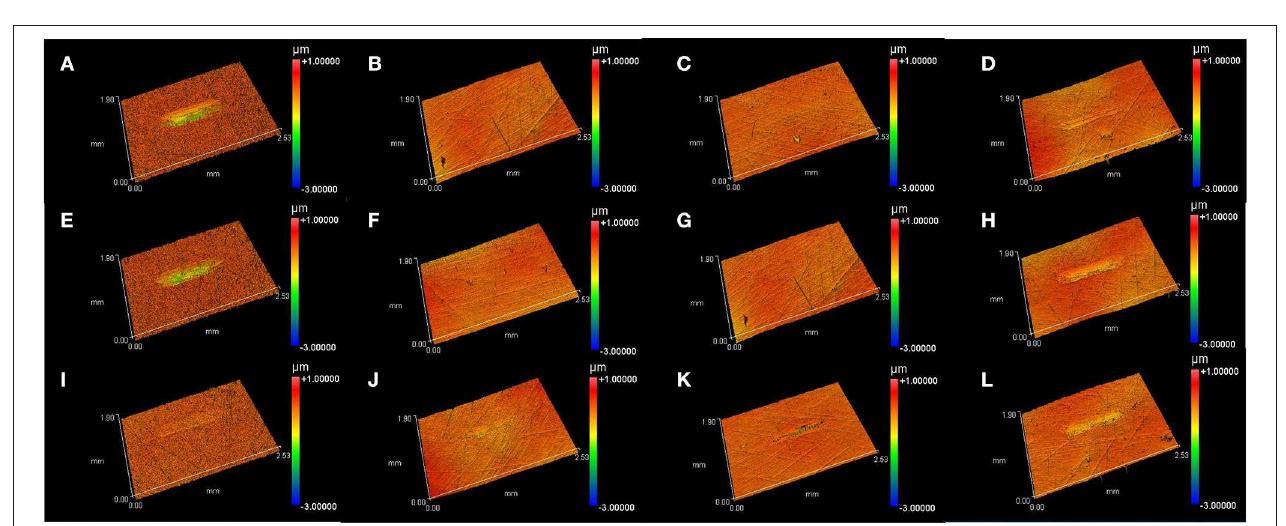
FIGURE 3 | 3D microscopic images of wear tracks on disc surfaces: (A) steel disc lubricated with L-[CH][Pro]-1.5GPa, (B) Tribobond 40 DLC lubricated with L-[CH][Pro]-1.5GPa, (C) Tribobond 43 DLC lubricated with L-[CH][Pro]-1.5GPa, (D) Tribobond 44 DLC lubricated with L-[CH][Pro]-1.5GPa, (E) steel disc lubricated with L-[CH][Pro]-2.0GPa, (F) Tribobond 40 DLC lubricated with L-[CH][Pro]-2.0GPa, (G) Tribobond 43 DLC lubricated with L-[CH][Pro]-2.0GPa, (H) Tribobond 44 DLC lubricated with L-[CH][Pro]-2.0GPa, (I) steel disc lubricated with GW/S5-2.0GPa, (J) Tribobond 40 DLC lubricated with GW/S5-2.0GPa, (K) Tribobond 43 DLC lubricated with GW/S5-2.0GPa, (L) Tribobond 44 DLC lubricated with GW/S5-2.0GPa.